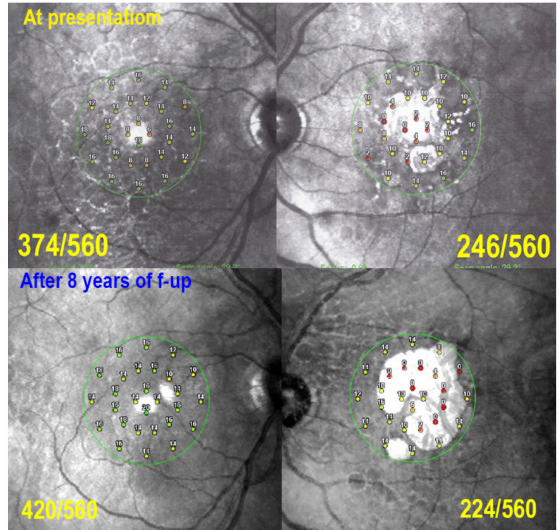
Figure 19. Serpiginous choroiditis: microperimetry follow-up. At presentation, there is a decrease of retinal sensitivity OD shown by microperimetry (374/560, top left ), due to occult choriocapillaris hypo-perfusion seen on ICGA (see Figure 16). On the left side ( top right ), there is a substantial decrease of retinal sensitivity mainly due to chorioretinal atrophy (246/560, top right, see Figure 16). After 8 years of follow-up, under IS retinal sensitivity recovered OD (420/560, bottom left ) and only slightly decreased OS (224/560, bottom right ), indicating efficiency of prolonged